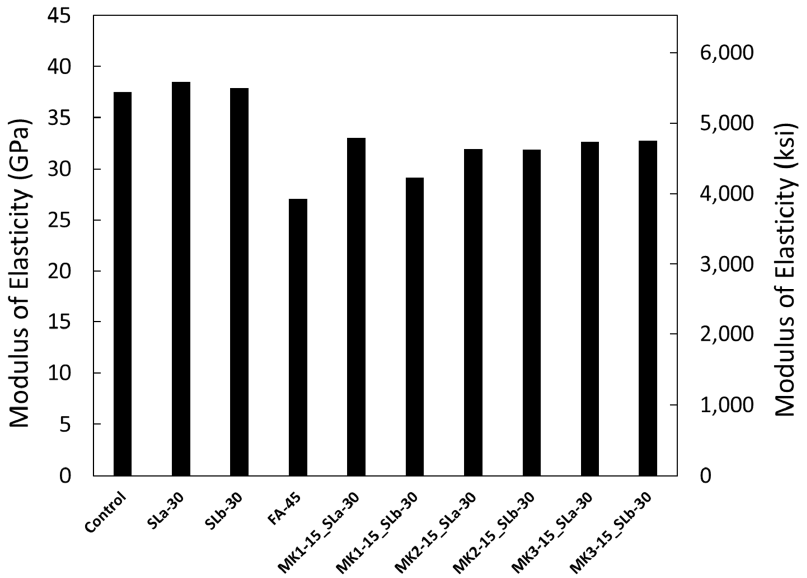
Figure 4. Dynamic Young’s modulus of non-metakaolin, binary and ternary SCM mixtures.